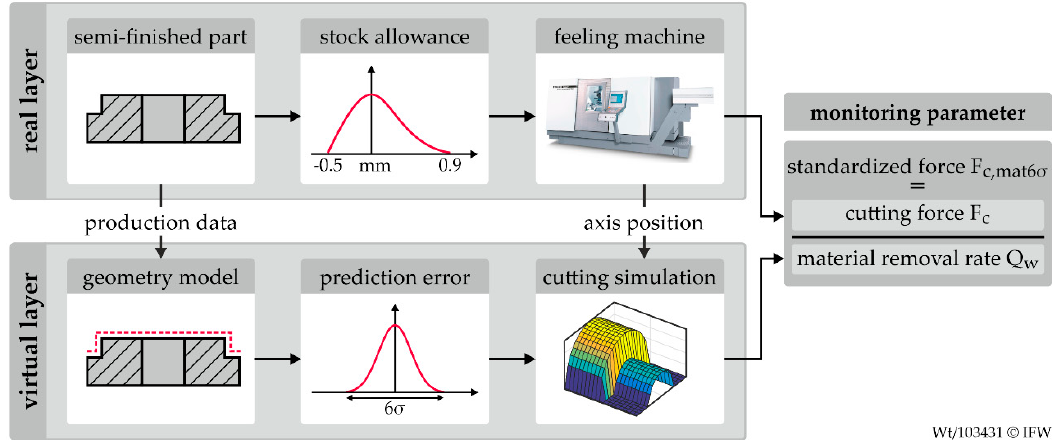
Figure 2. Visualization of the signal flow diagram for the determination of the material ‐ specific cutting force.